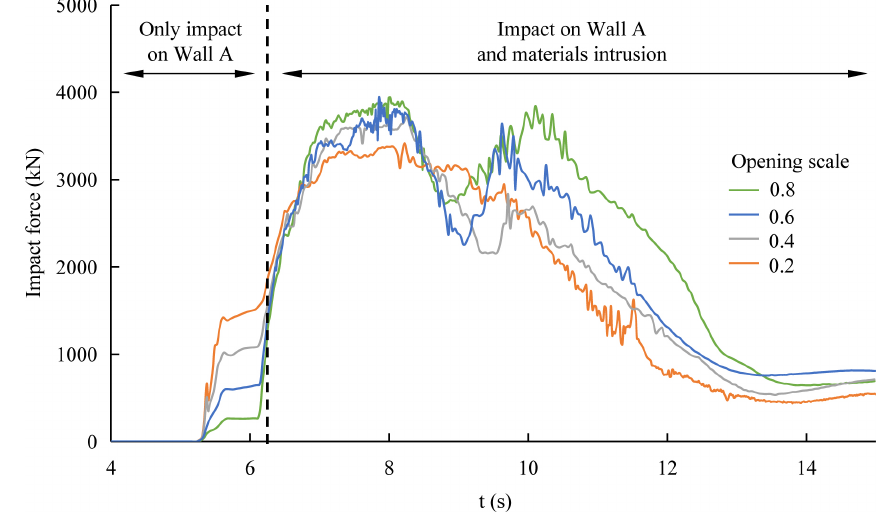
Figure 21. Impact force time history with changing opening scales in the scenarios of Or90-Opx- A null- D null after a simulation time of